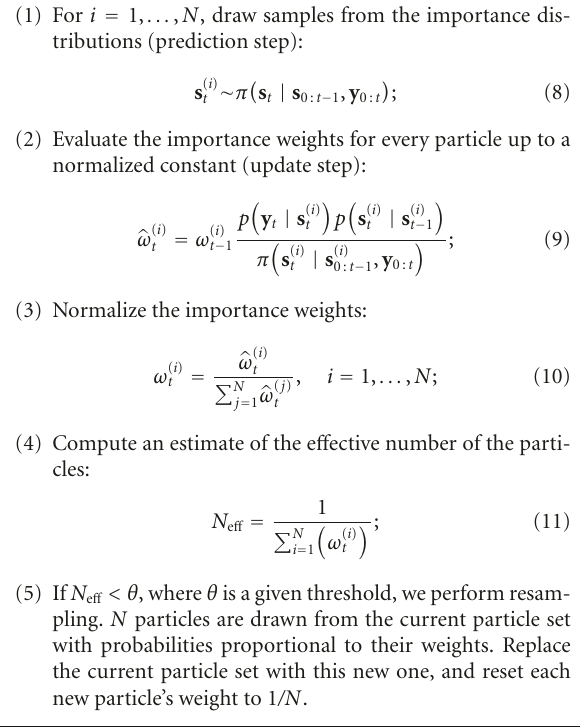
Algorithm 1: SIS/SIR particle